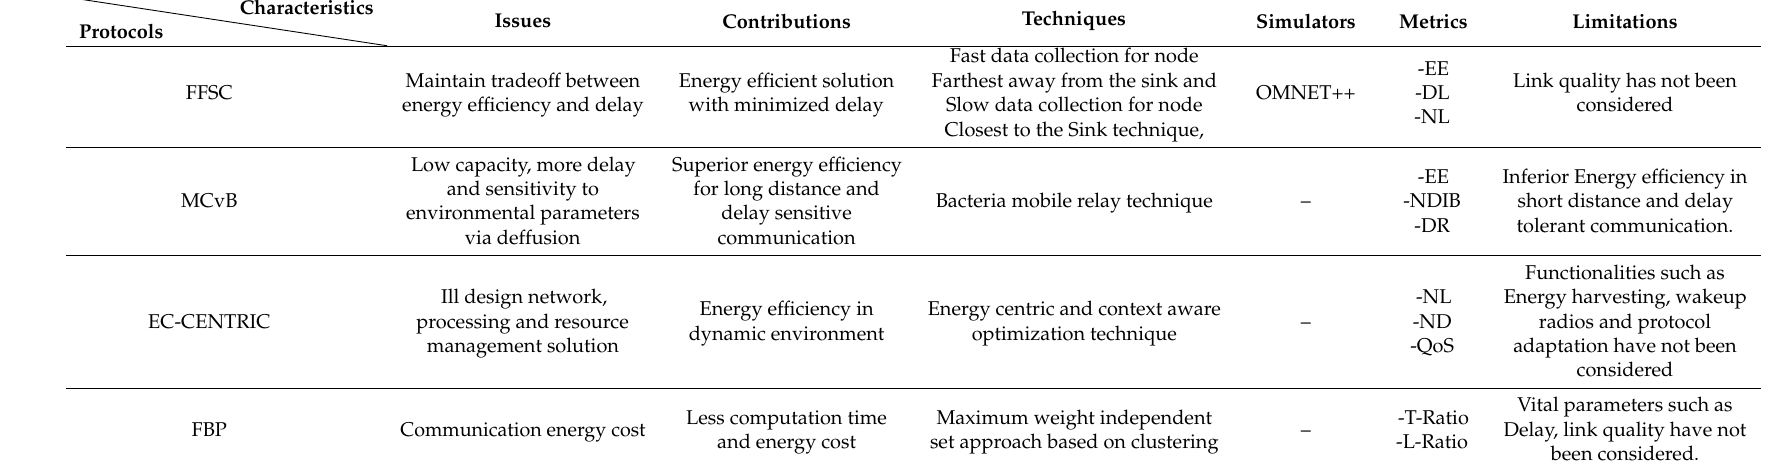
Table 12. Summary of energy efficient communication techniques.